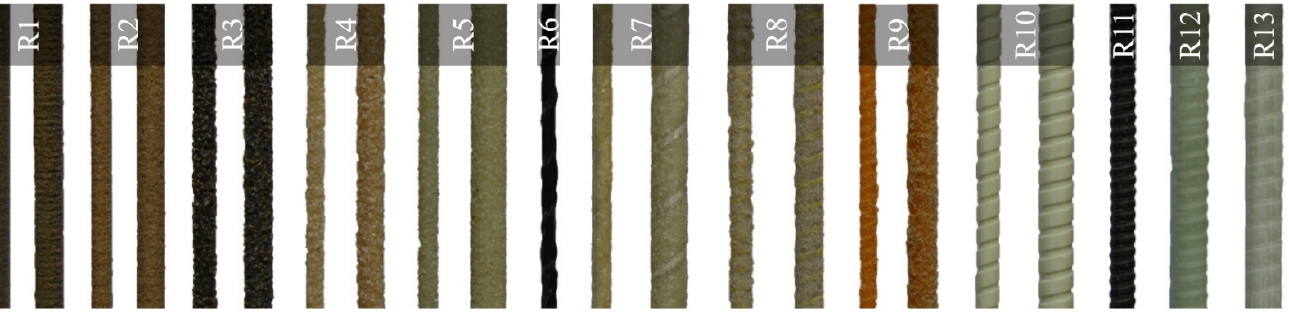
Figure 4. Surface deformation shapes of FRP rebars [58]. Figure 3. Surface deformation shapes of FRP rebars